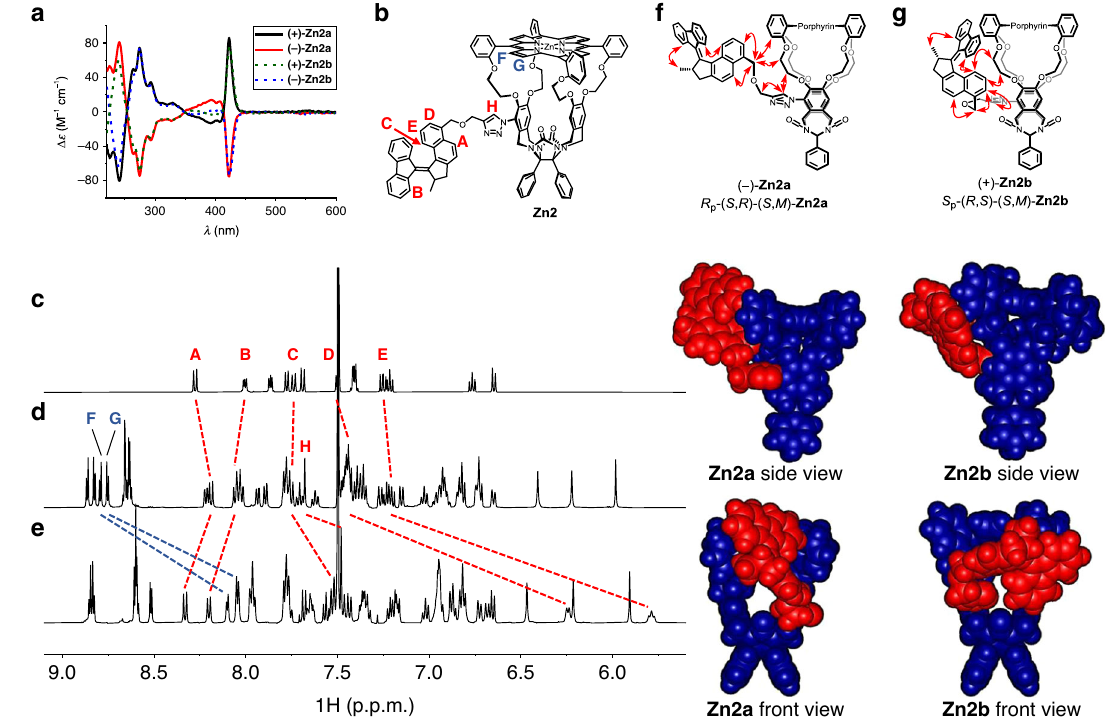
Fig. 3 Characterization of motor compounds. a CD spectra of ( + )- Zn2a , ( − )- Zn2a , ( + )- Zn2b , and ( − )- Zn2b in CH 2 Cl 2 ( c = 3.9 × 10 − 5 M, 298 K). b Molecular structure of Zn2 , with protons A – H indicated. c – e 500 MHz 1 H NMR spectra of 8 , Zn2a , and Zn2b , respectively ( c = 10 − 3 M in CDCl 3 /CD 3 CN, 1 : 1, v/v, 298 K), with the changes in chemical shift of motor protons A – E and H indicated in red and those of the macrocycle protons F – G in blue. f , g Key NOEs (red arrows) observed for the motor protons of Zn2a and Zn2b , and Spartan-calculated three-dimensional structures of ( − )- R p -( S , R )-( S , M )- Zn2a and ( + )- S p -( R , S )-( S , M )- Zn2b , based on the observed NOEs. Atoms of the molecular motor moiety and the macrocycle are indicated in red and blue,